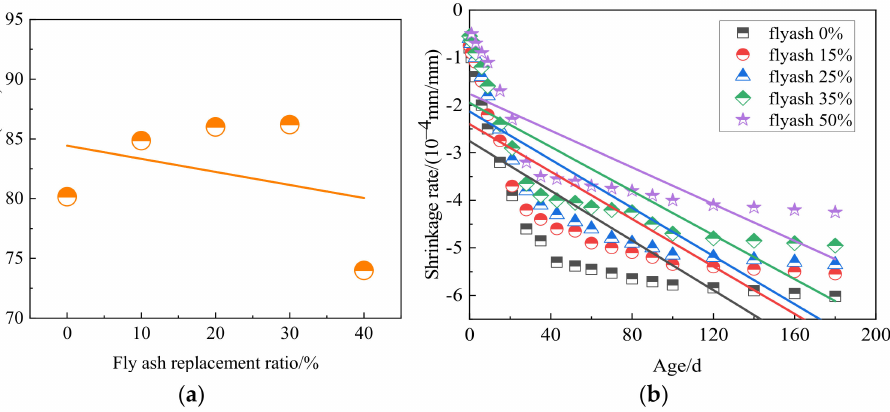
Figure 19. ( a ) Average value of micro-hardness in interface transition zone with different fly ash content [98]; ( b ) Effect of different fly ash content on concrete shrinkage